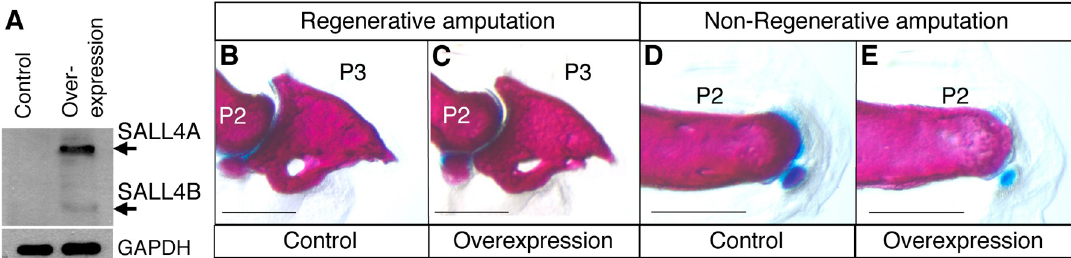
Fig 5. Sall4 overexpression does not alter the regenerative ability of the digit tip. (A) Western blotting of lysate from TCre +/+ ; R26-Sall4 +/Tg and TCre +/tg ; R26-Sall4 +/tg neonatal digits. Arrows point to SALL4A and SALL4B bands. (B, C) Alcian blue/Alizarin red- stained digits from 21 day-old control ( TCre +/tg ; R26-Sall4 +/+ ) and Sall4 -overexpression ( TCre +/tg ; R26-Sall4 +/tg ) mice, amputated at the tip of the terminal phalange level at the P0 stage. (D, E) Alcian blue/Alizarin red-stained digits from 21 day-old control ( TCre +/tg ; R26-Sall4 +/+ ) and Sall4 -overexpression ( TCre +/tg ; R26-Sall4 +/tg ) mice, amputated at the second phalange level at the neonatal stage. Scale bar: 500 μ m in B-E. P2 and P3 in panels B-E indicate the second phalange and the terminal phalange, respectively.